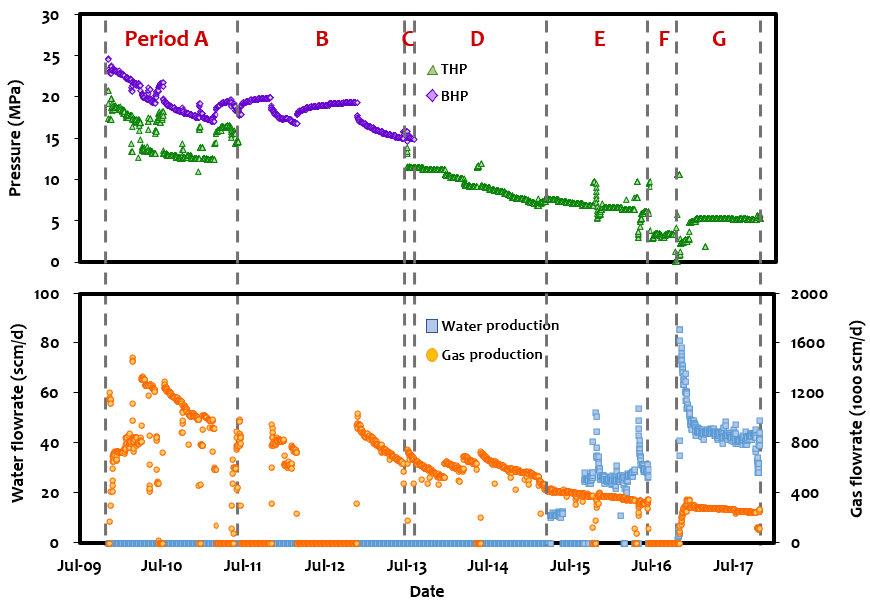
Figure 2. Production profile of the target well (scm: standard cubic meters).